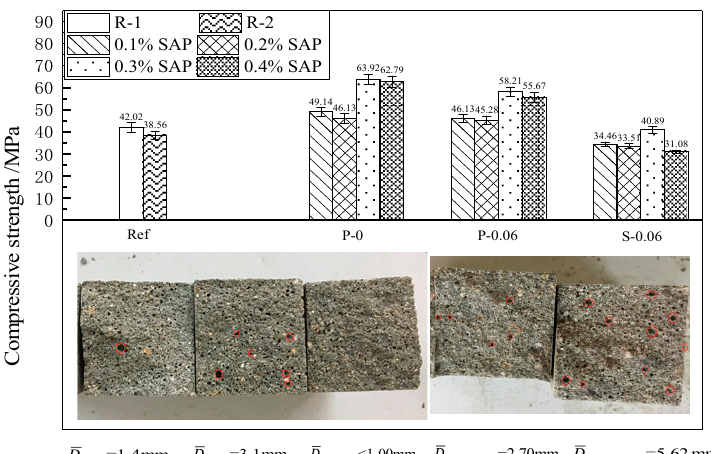
Figure 5. Compressive strength of cement mortar with different adding methods of SAP.